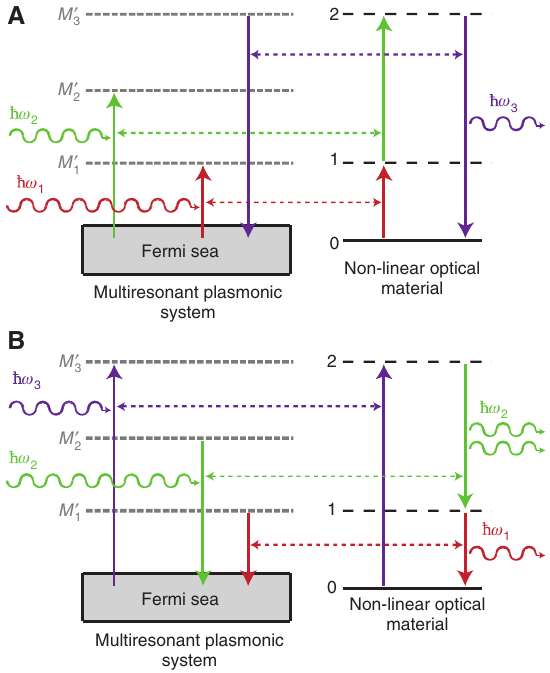
Figure 10: Energy diagram illustration of multiresonant plasmonic enhancement of nanoscale parametric nonlinear optical processes by integrating the nonlinear optical material with a multiresonant plasmonic system with spatial mode overlap. (A) The three-photon sum-frequency process. (B) The three-photon optical parametric amplification